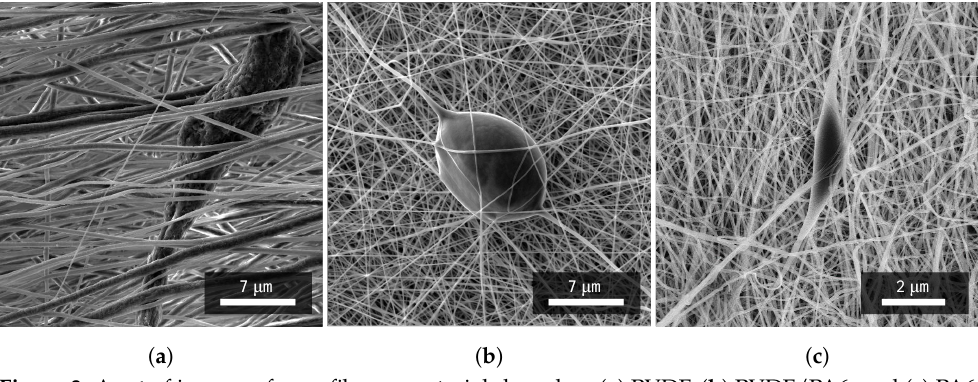
Figure 3. A set of images of nanofibrous materials based on ( a ) PVDF, ( b ) PVDF/PA6, and ( c ) PA6; and their typical occurring defects. It can be seen that the most common defect in the fibers is a tear- shaped droplet in all materials. Measurement parameters: acceleration voltage 5kV, magnification 9.4k ×